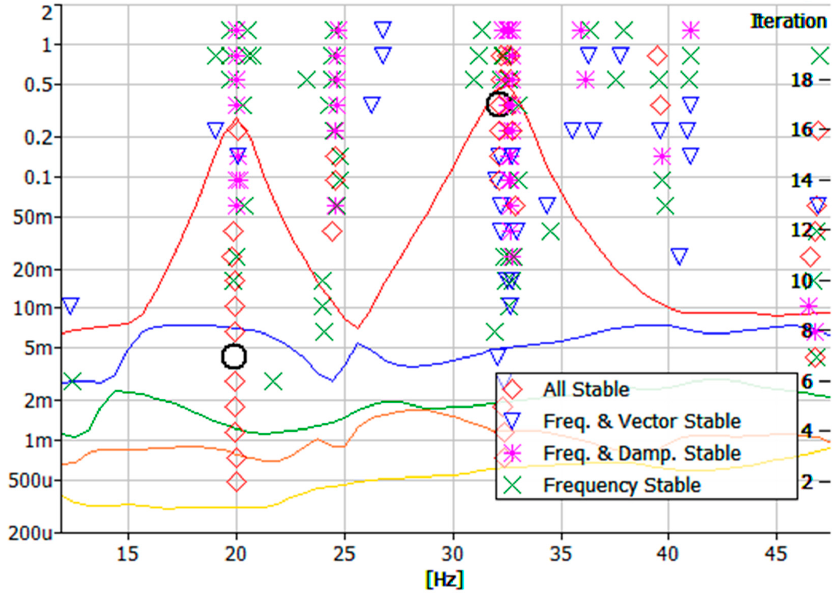
Figure 4. Stabilization diagram with rational fraction polynomial—Z algorithm.